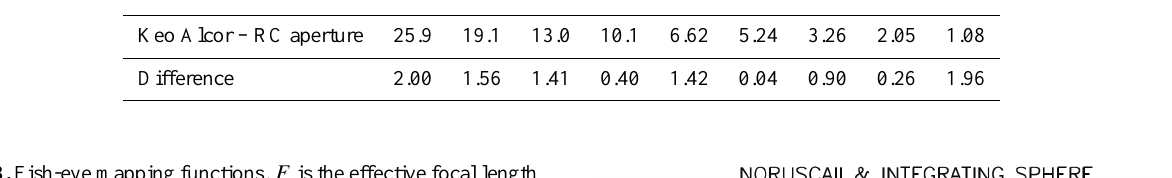
Table 2. The difference in spectral calibration between UNIS – FICS and NRC of the Keo Alcor-RC low brightness source as a function of aperture. All numbers are in units of %.